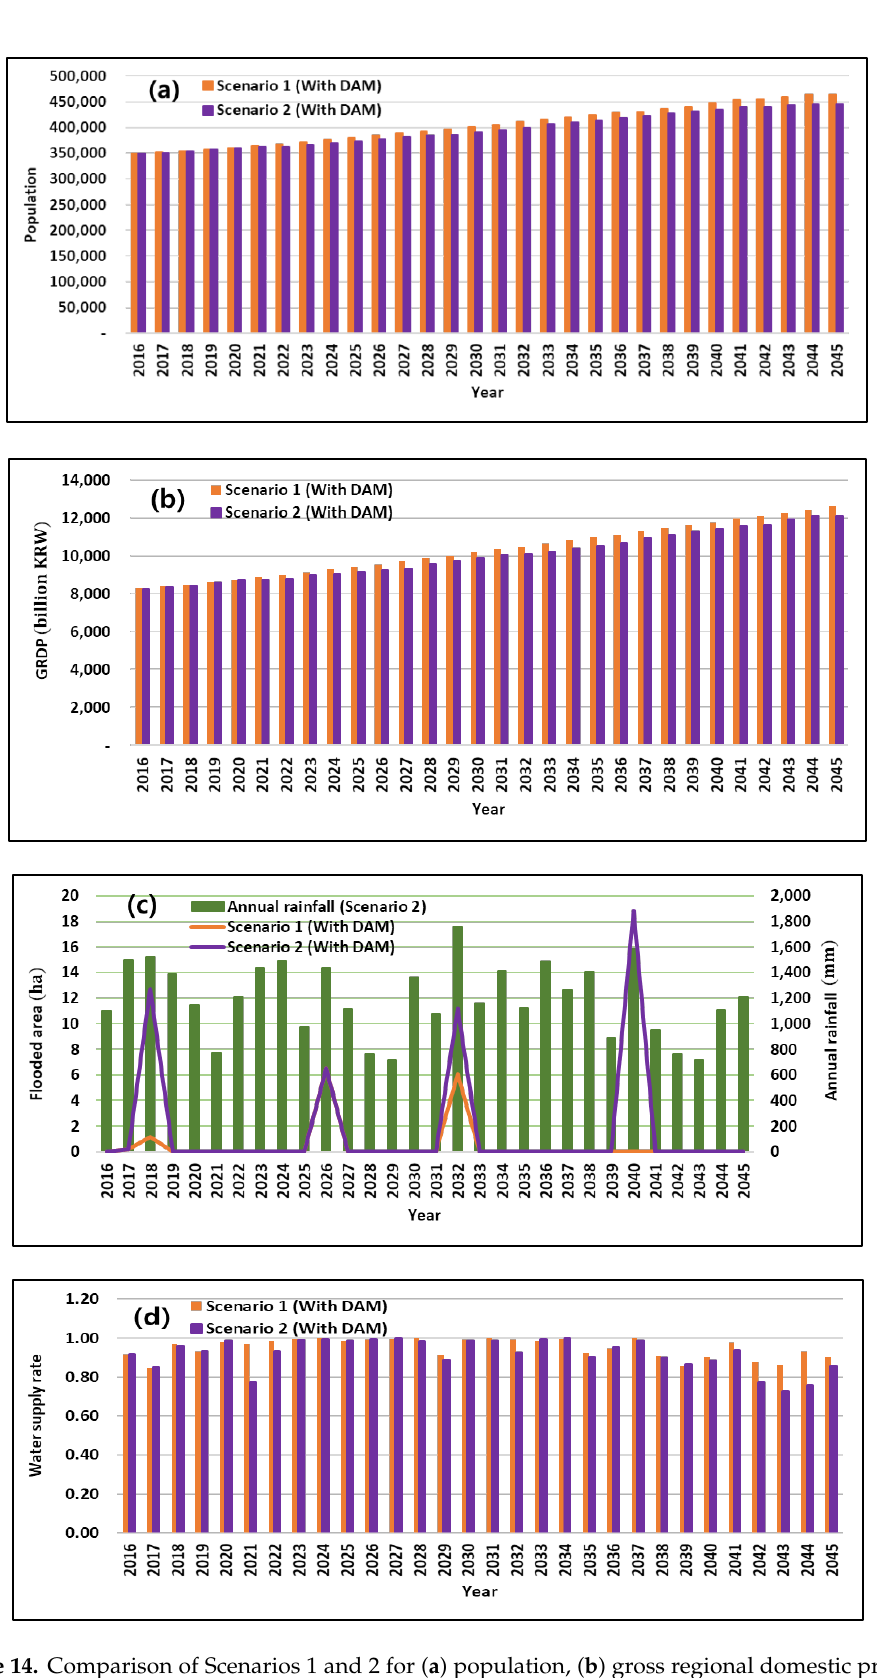
Figure 14. Comparison of Scenarios 1 and 2 for ( a ) population, ( b ) gross regional domestic product (GRDP), ( c ) flooded area, and ( d ) water supply rate.